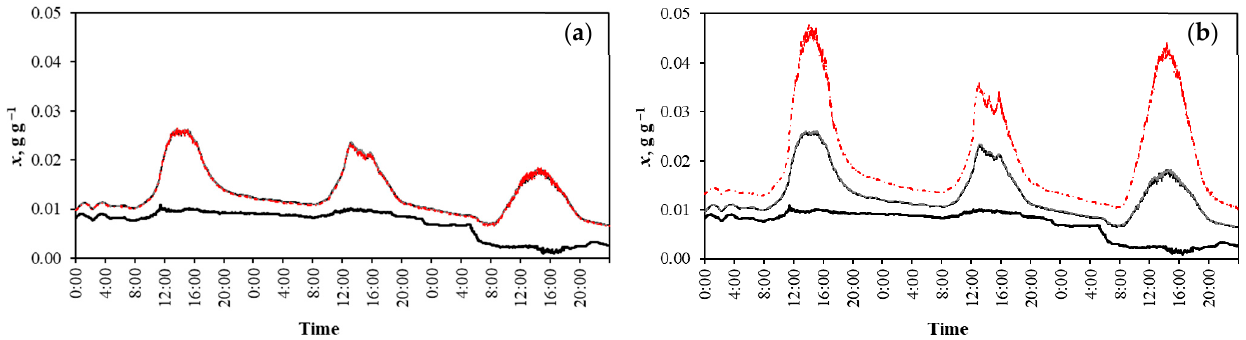
Figure 4. Humidity values in the zone without low tunnel ( a ) and in the zone with low tunnel ( b ) measured from the 3 to 5 March 2015: at 2 m ( ─ ), 1 m ( --- ) and 0.2 m ( -·- ) in height; outside ( ▬ ).